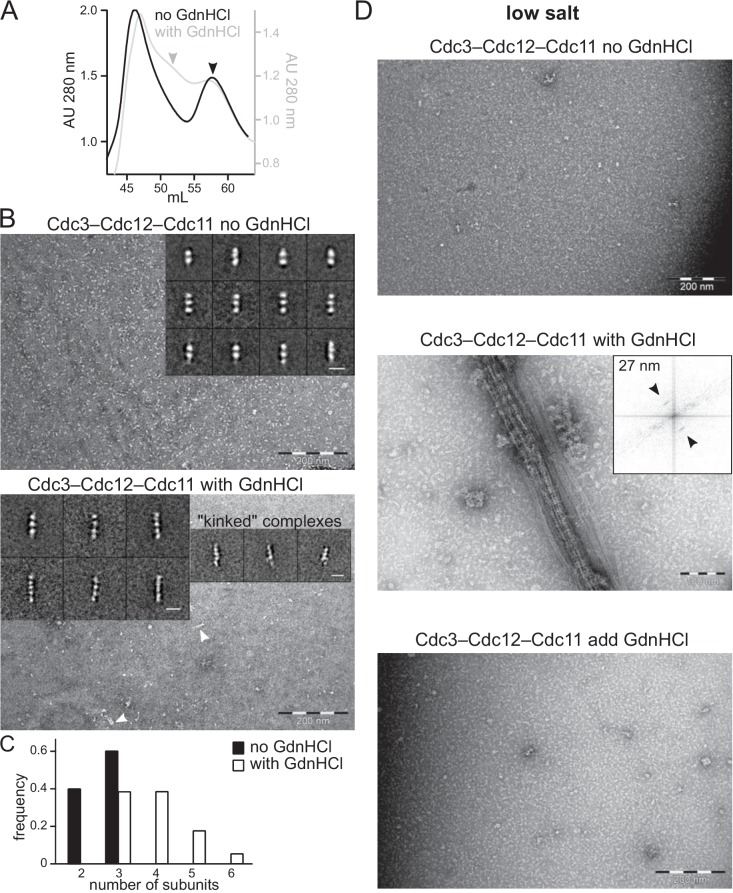
GdnHCl promotes higher-order assembly by recombinant Cdc10-less septin hexamers produced in E. coli.Complexes purified from E. coli cells co-expressing Cdc3, Cdc11, and 6xHis-Cdc12 in the absence or presence of 50 mM GdnHCl, as indicated, were analyzed by size-exclusion chromatography (SEC) in high-salt (300 mM NaCl) buffer, to prevent filament polymerization, and fractions containing the peak of protein, as judged by absorbance at 280 nm, were examined with an electron microscope. (A) SEC elution profiles overlaid to illustrate the appearance of a new peak of larger particles (eluting at ~ 52 mL) in the samples prepared with GdnHCl. Arrowheads indicate the peaks from which fractions were taken for EM analysis. The void volume (~46 mL) contains protein aggregates. ‘AU’, absorbance units. (B) EM analysis of samples indicated in (A) were exchanged into non-polymerizing high-salt buffer (50 mM Tris-HCl pH 8, 300 mM NaCl with or without 50 mM GdnHCl). Arrowheads point to complexes longer than trimers. Inserts display representative class averages resulting from image processing, with 10 nm scale bars. (C) Frequency distribution of sizes of particles found in high-salt samples, from 4233 particles of the sample produced without GdnHCl and 3247 particles produced with GdnHCl. (D) As in (B) but following dilution into polymerizing (‘low salt’, 50 mM Tris-HCl pH 8, 50 mM NaCl with or without GdnHCl) conditions. Insert shows the Fourier transform of a bundle of filaments as in the image beneath it, with arrows pointing at diffraction peaks reflecting repetitive distances of 27 nm. The bottom panel shows complexes synthesized and purified in the absence of GdnHCl to which GdnHCl was added to 50 mM prior to dilution in low salt buffer also containing 50 mM GdnHCl.
Figure 3—source data 1.Absorbance values at 280 nm at each elution volume for Figure 3A.

Figure 3—source data 2.Particle size values for Figure 3C.